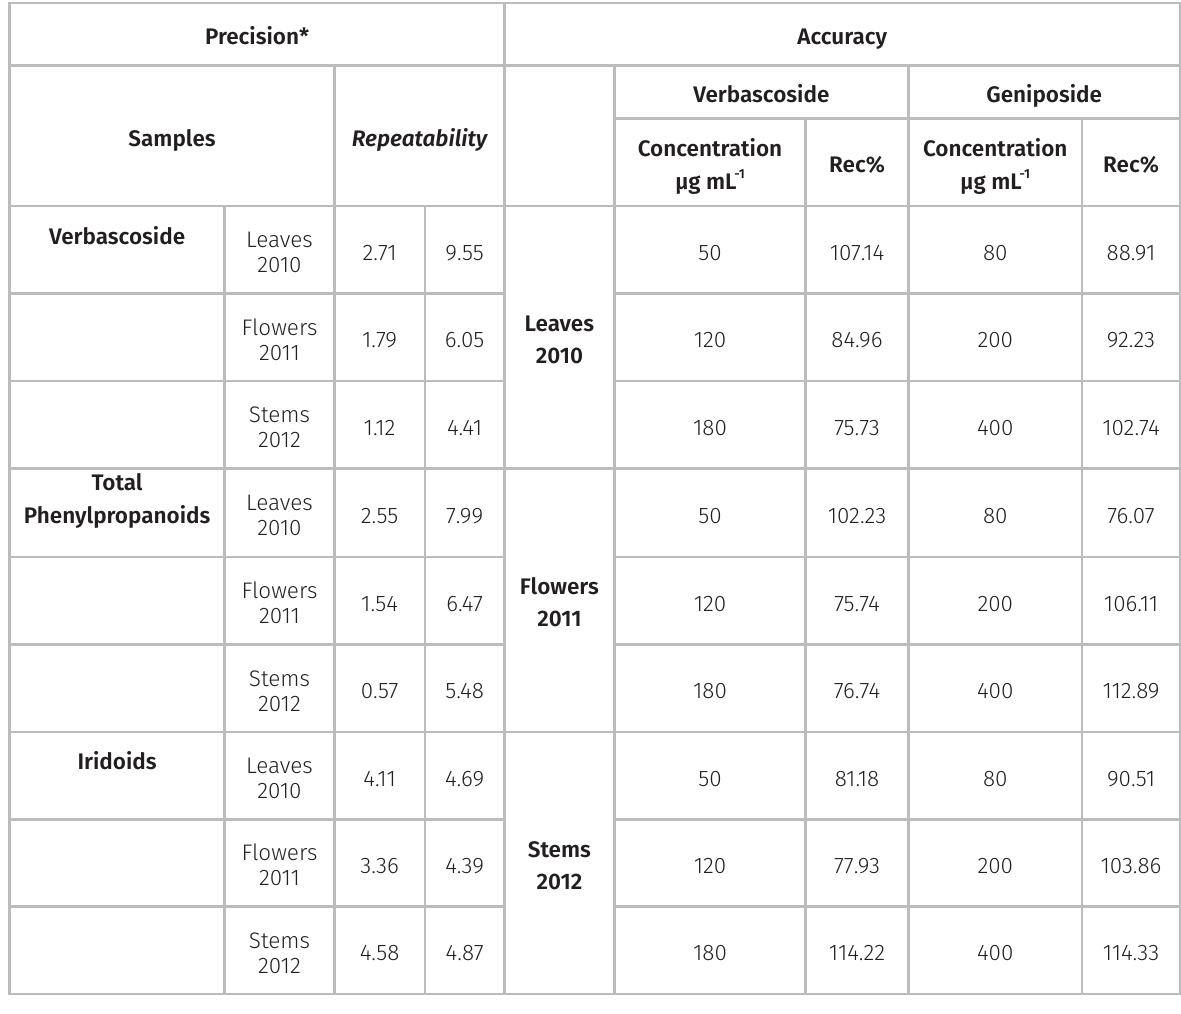
Table II. Precision (Repeatability and Intermediate precision, i) and accuracy tests (Recovery percentage, Rec% ) for quantitation of verbascoside, phenylpropanoids and iridoids (as geniposide equivalent) in aerial parts of Verbena minutiflora